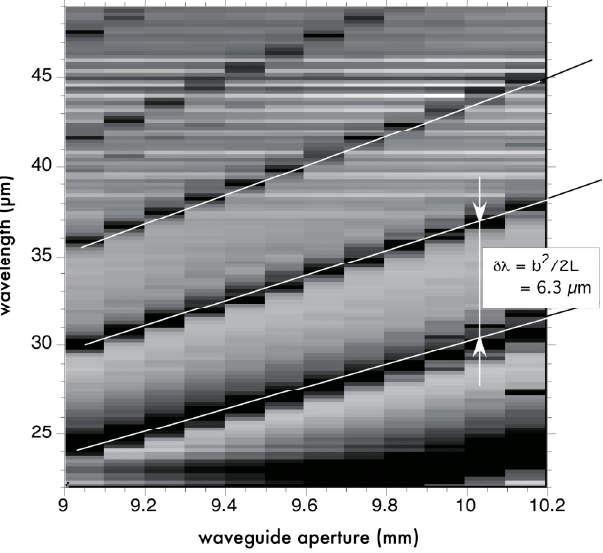
FIG. 14. Simulation—ELBE FEL power vs wavelength and waveguide aperture b